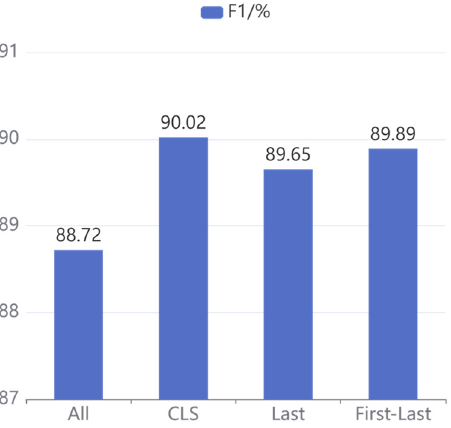
Figure 8. Comparison results for different sentence vectors on CCKS2020.